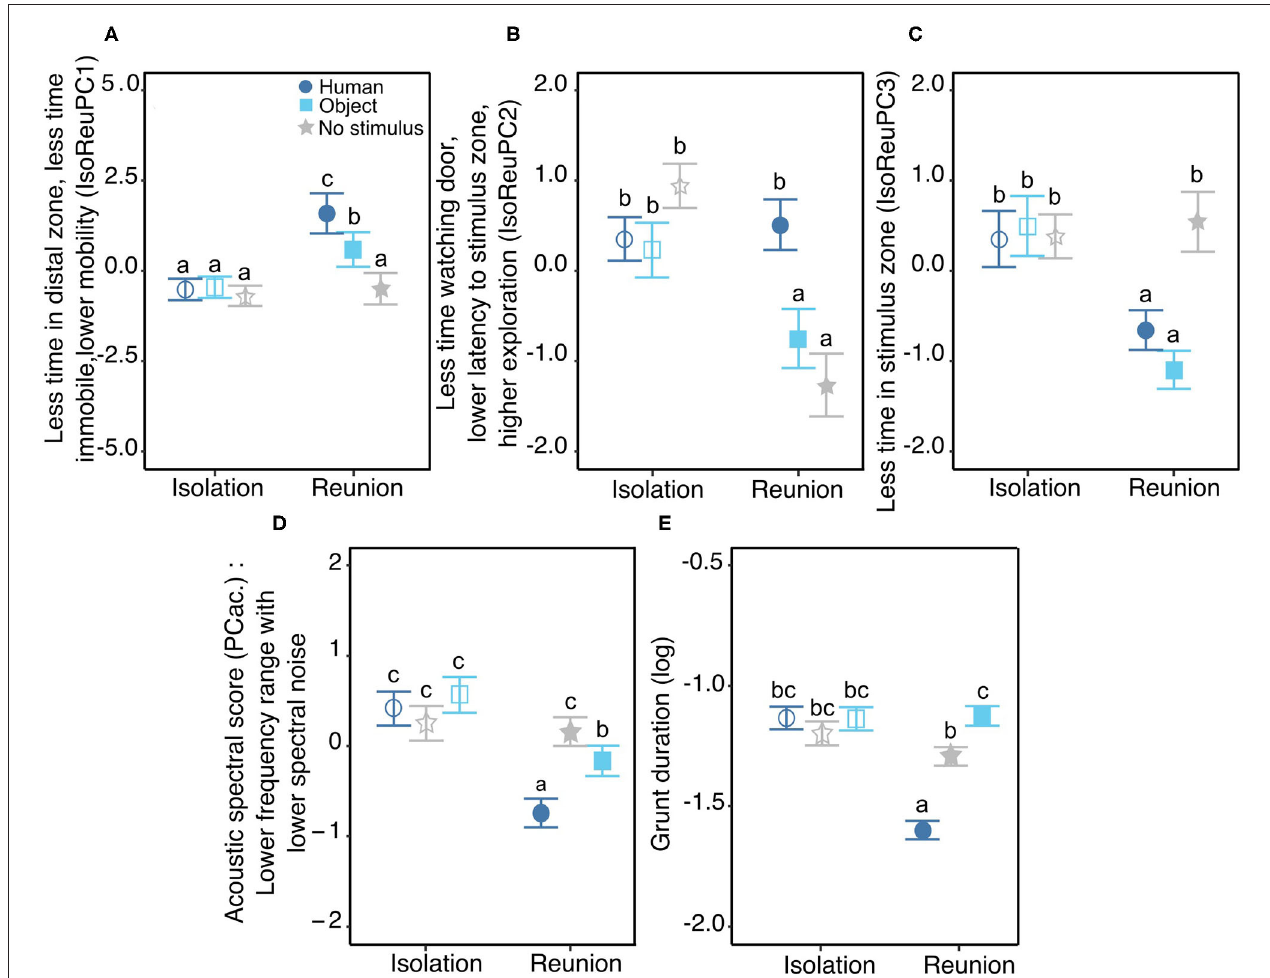
FIGURE 3 | Behavioral (A–C) and vocal (D,E) responses to the Isolation/Reunion test. Mean ( ± se) of behavioral and acoustic scores, according to the stimulus (Human = dark blue circles, Object = light blue squares, No stimulus = gray stars), the phase of the test (Isolation = empty symbols or Reunion = filled symbols) and/or the day of the test (day 1, 2, or 3). (A–C) significant interaction between the type of reunion and the phase of the test for the three behavioral response scores IsoReuPC1, IsoReuPC2, IsoReuPC3, respectively. (D,E) significant interaction between the type of reunion and the phase of the test for the two acoustic scores: the acoustic spectral score (D) and the logarithm of grunt duration (E) . Different letters show significantly different groups ( p < 0.05). All model estimates, anova tables, and results of post hoc tests are available in Supplementary Tables 4–6 . Description of each behavioral and each acoustic parameter depending on experimental conditions is available in Supplementary Tables 2, 3 , respectively.